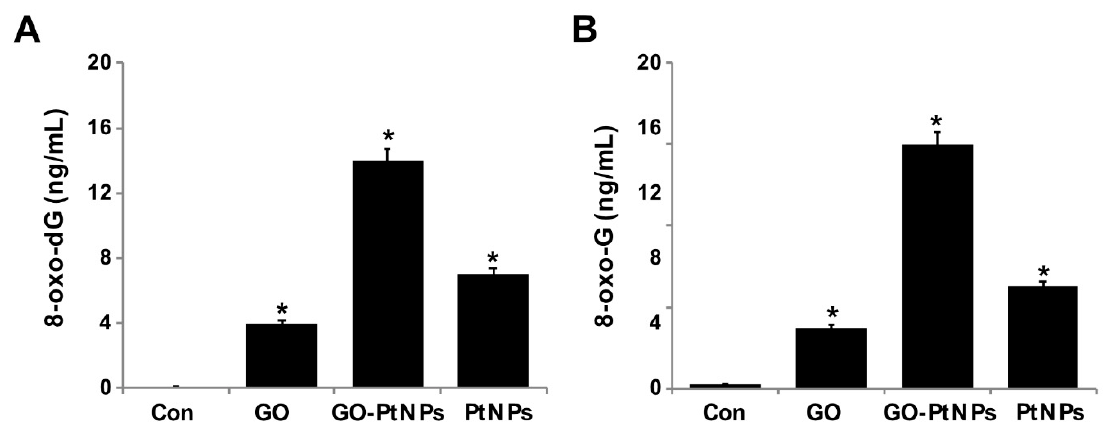
Figure 13. GO, GO-PtNPs, and PtNPs increase DNA damage. LNCaP cells were treated with respective IC50 concentration of GO, GO-PtNPs, and PtNPs for 24 h. 8-oxo-dG and 8-oxo-G were measured after 24 h of exposure of LNCaP cells. There was a significant difference in treated cells compared to untreated cells with Student’s t -test (* p < 0.05).